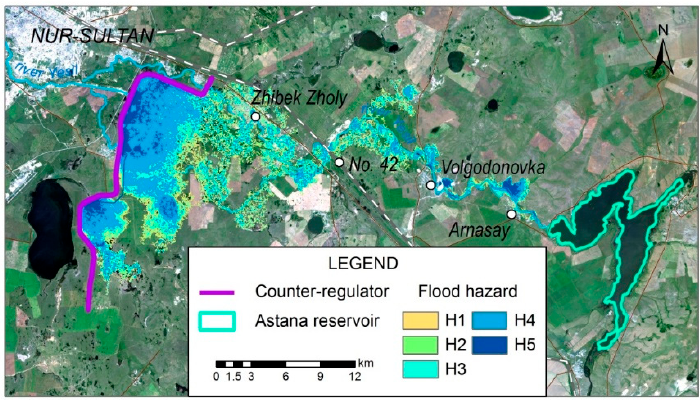
Figure 8. Hazard map (Classification 1) produced from the 20-year return period flow hydrograph.